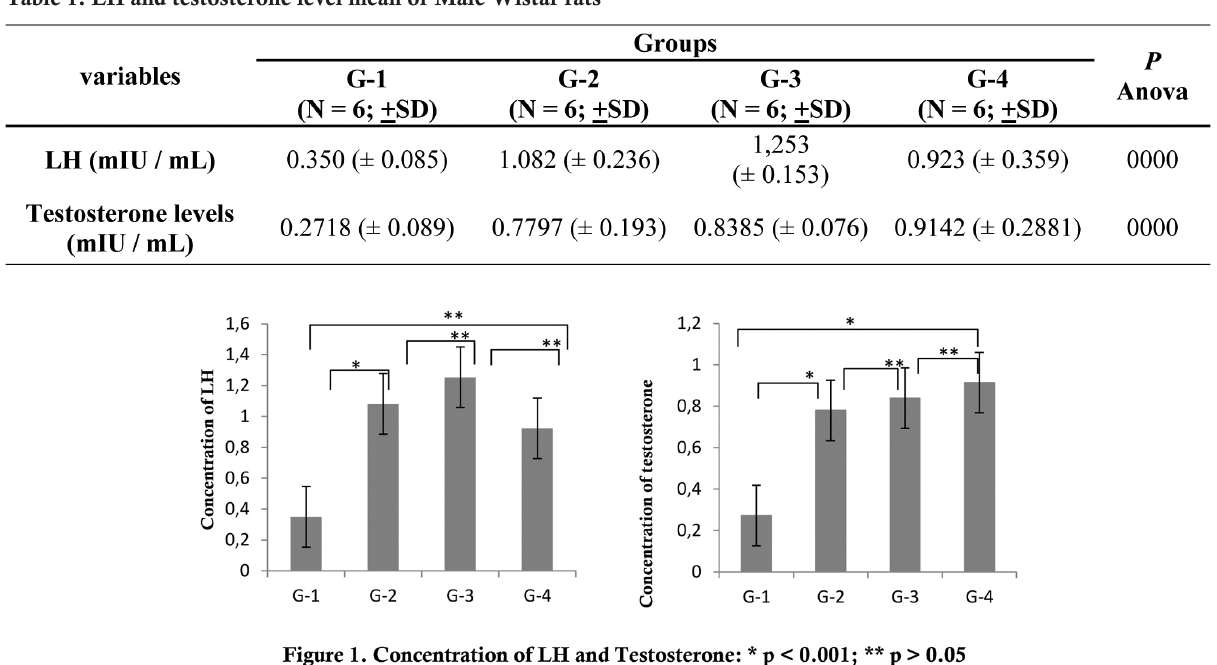
Table 1. LH and testosterone level mean of Male Wistar